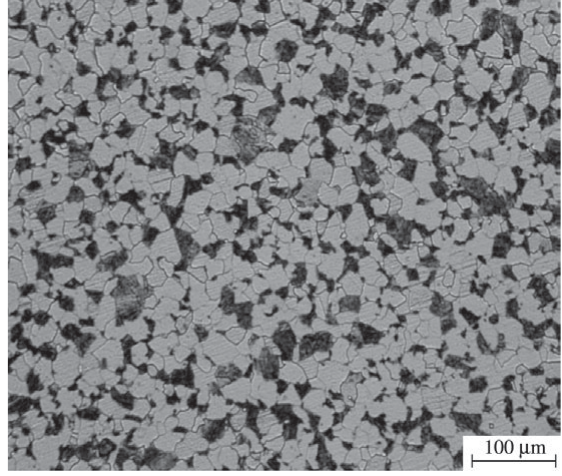
Figure 2. Micrography of the G11 steel sample before degrada- tion. Etching: Nital